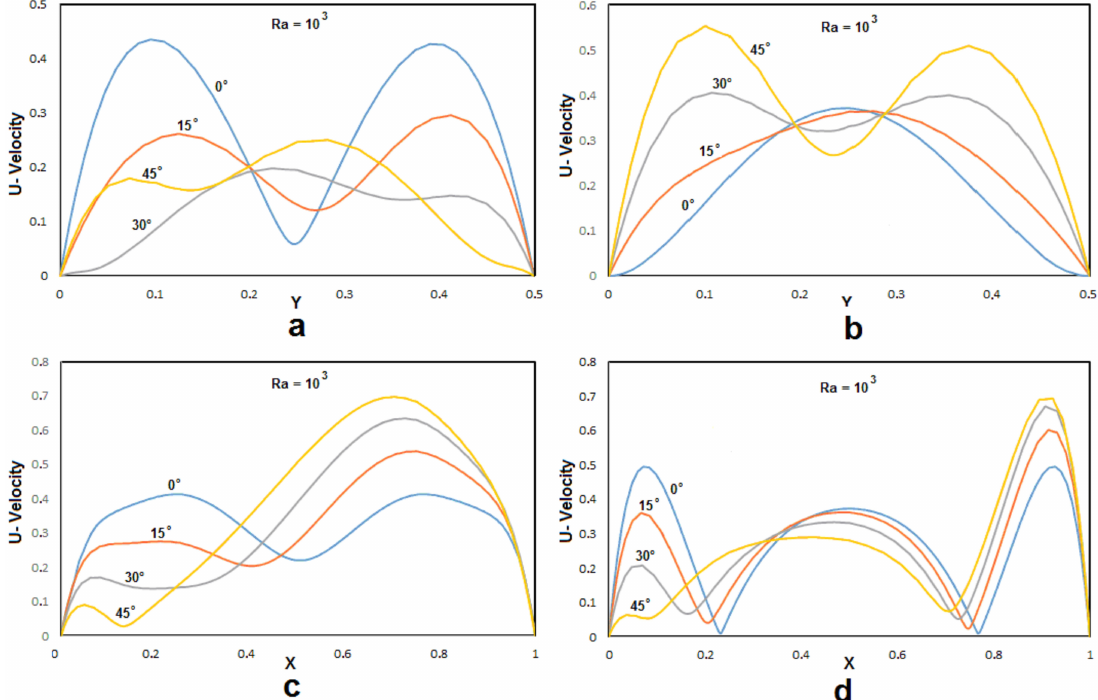
Figure 5. Nanofluid velocity evolutions at the levels: X = 0.25 ( a ) X = 0.5 ( b ) Y = 0.25 ( c ) Y = 0.5 ( d ) for a Rayleigh number Ra = 10 3